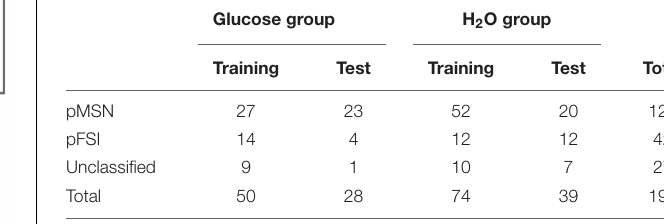
Frontiers in Pharmacology |